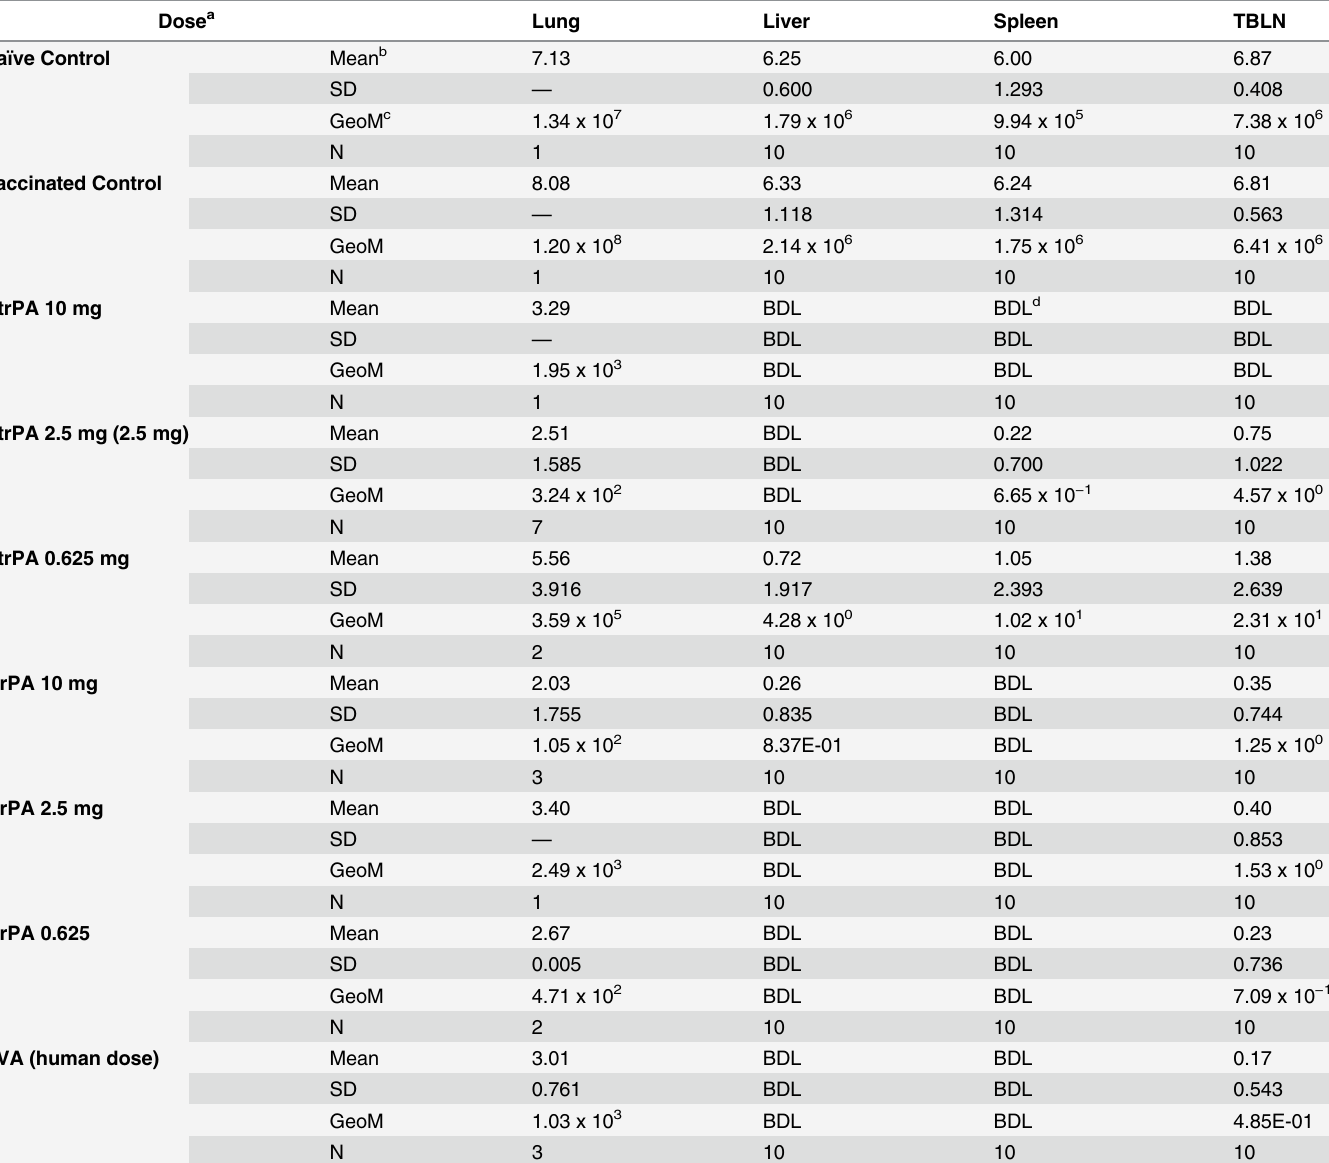
Table 6. Summary of Recovery of B . anthracis from Select Tissues of Inhalational Spore Challenged New Zealand White Rabbits. Dose a Lung Liver Spleen TBLN Na ï ve Control